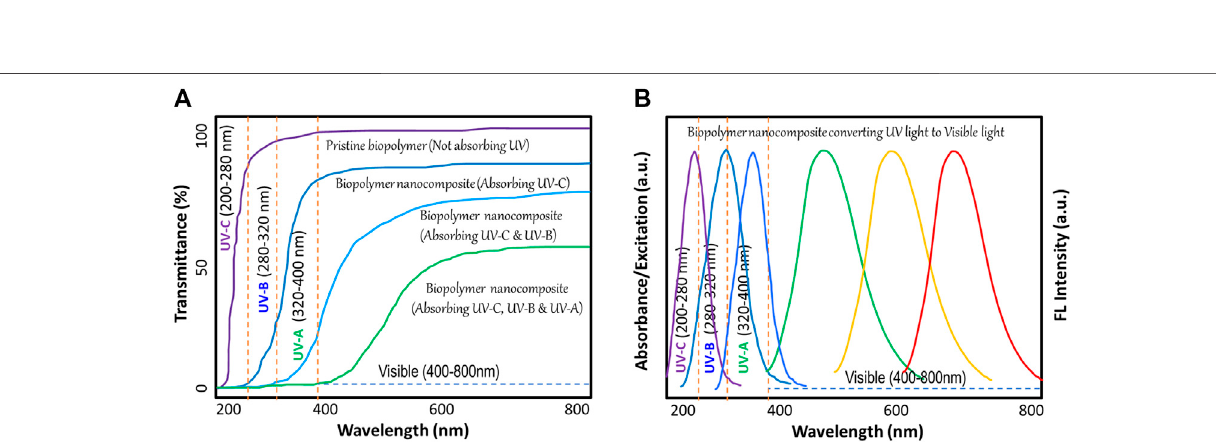
FIGURE 6 | Schematic showing UV protection mechanism of pristine biopolymer (A) and biopolymer nanocomposite when exposed to UV, Visible, and IR radiation (B) .